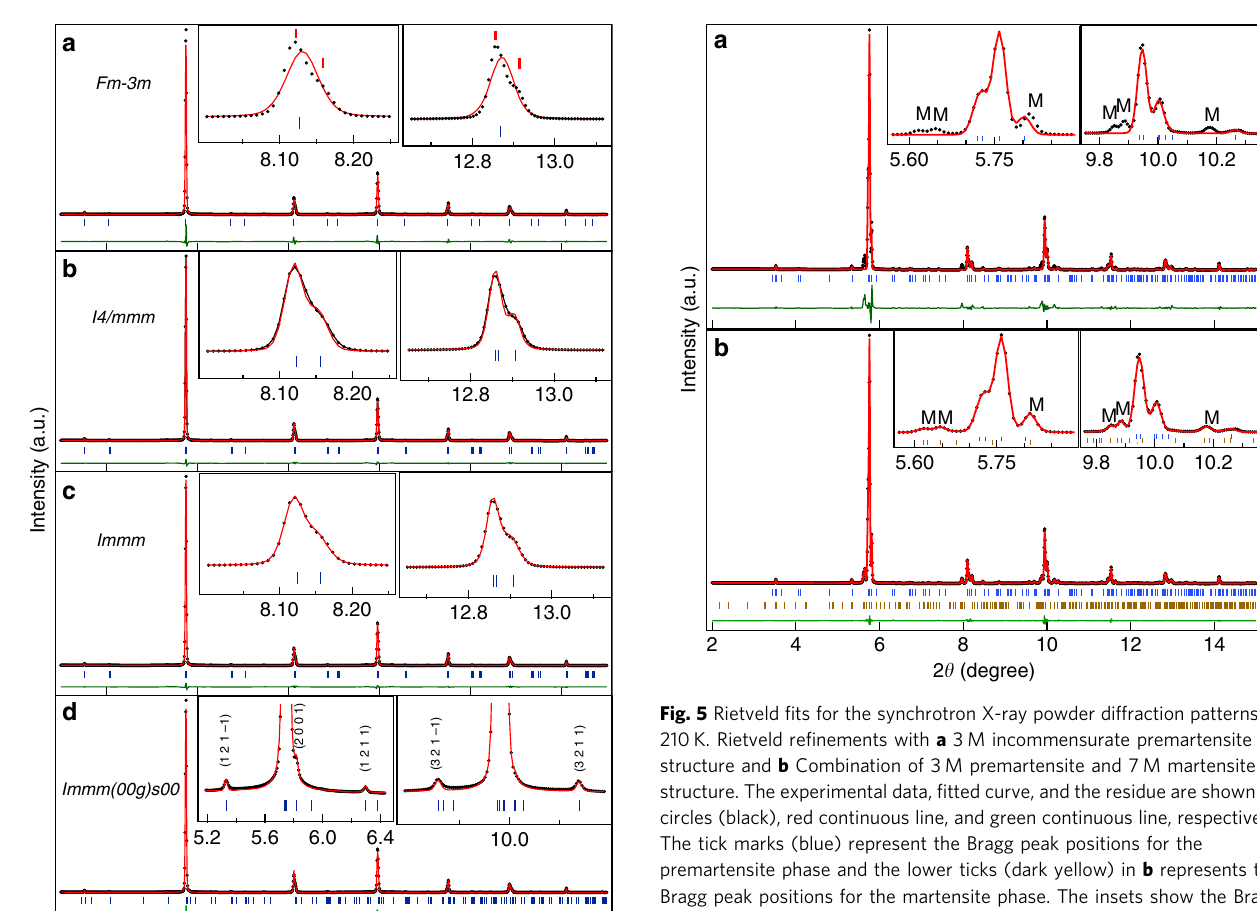
Fig. 6a that unit cell volume for all the phases decreases with